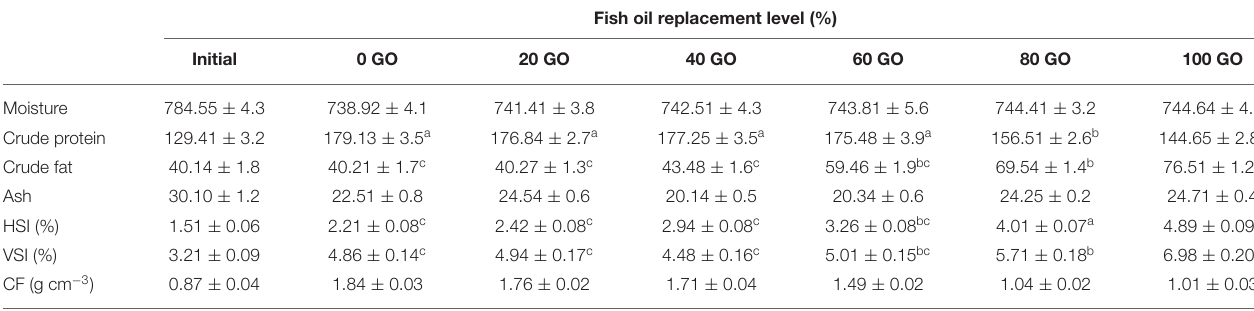
TABLE 4 | Carcass compositions (g kg − 1 , wet basis), and biological indices of fingerling Labeo rohita fed different experimental diets * , **